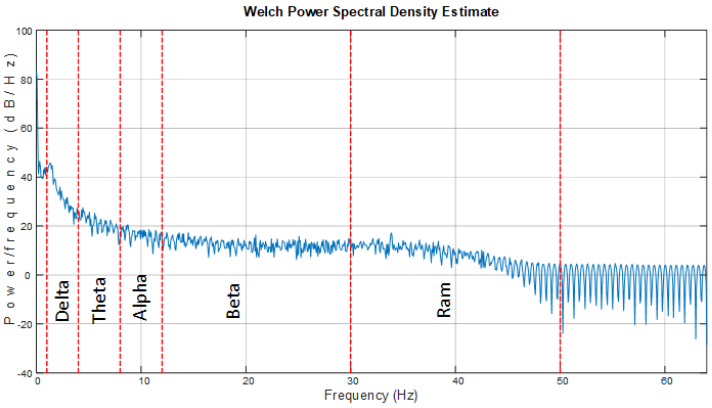
Figure 6. Band power separation example, Welch power spectral density estimate (illustrative figure).